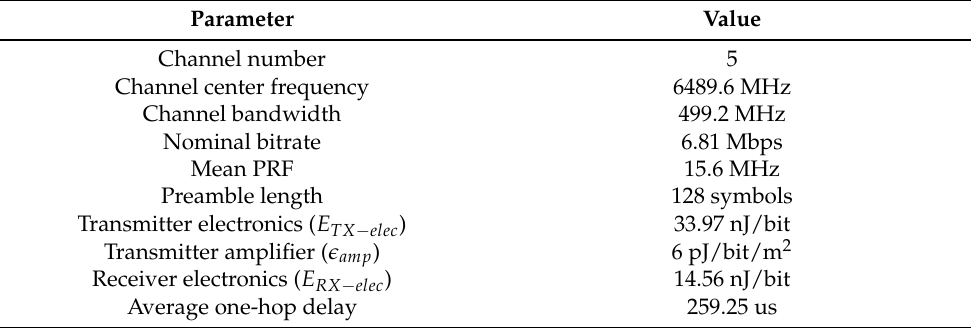
Table 1. The UWB radio configuration